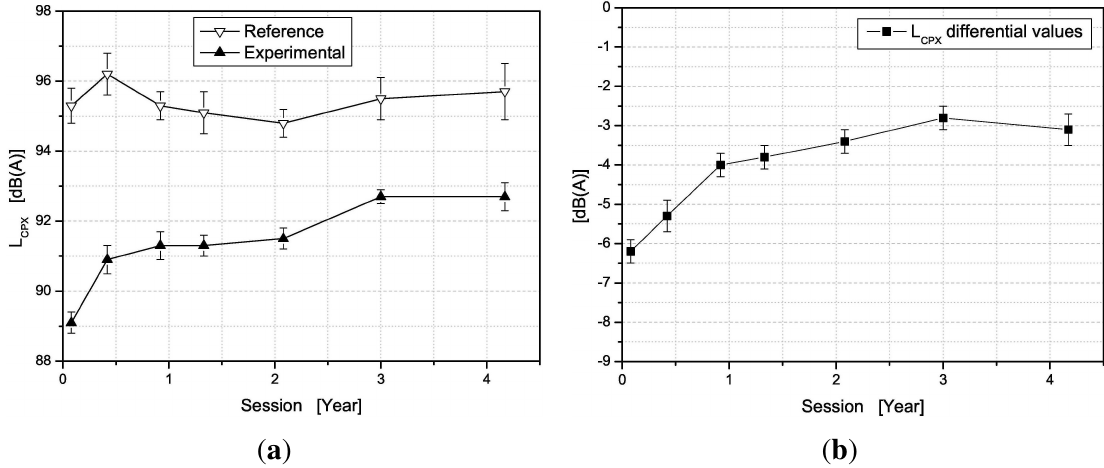
Figure 12. Absolute ( a ) and differential ( b ) values of L (e.g., time, in years) for the Dense grade 0/6 with expanded clay laid in Site